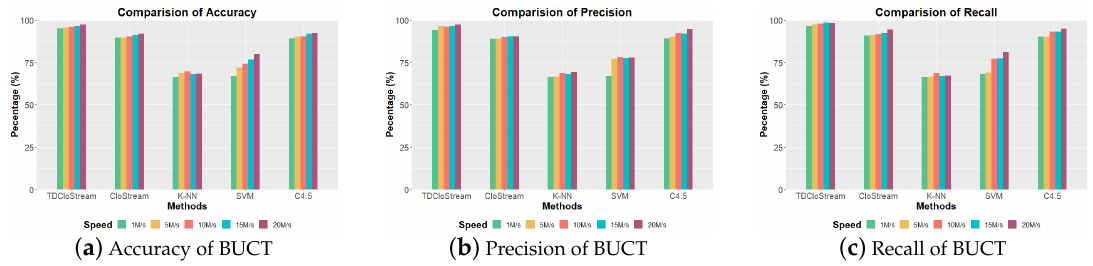
Figure 4. Accuracy, precision and recall of the BUCT